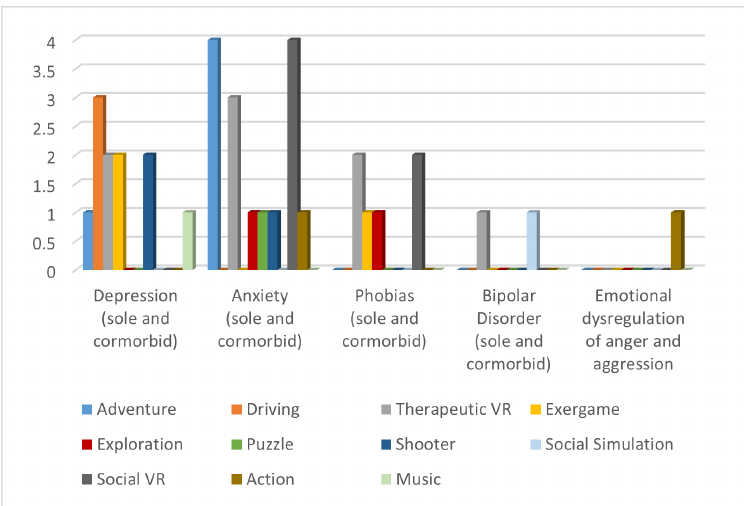
Figure 5. Genre of the games used for each affective